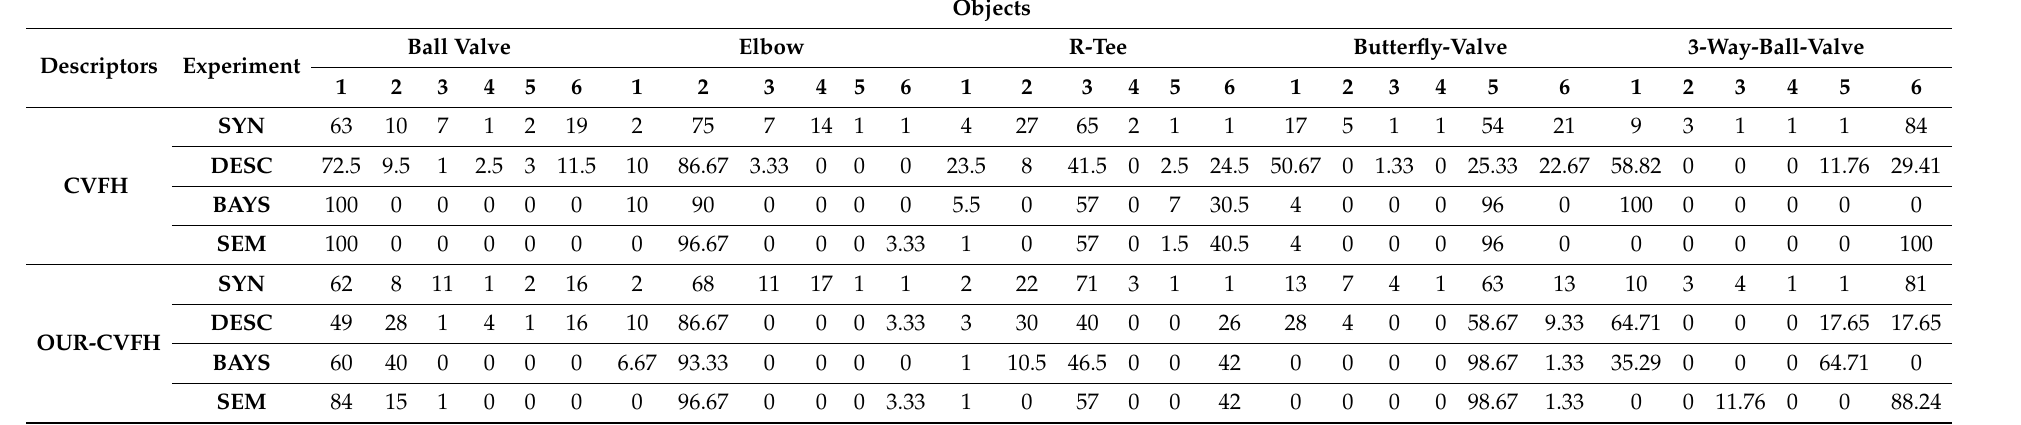
Table 3. Confusion Matrices expressed as a numerical